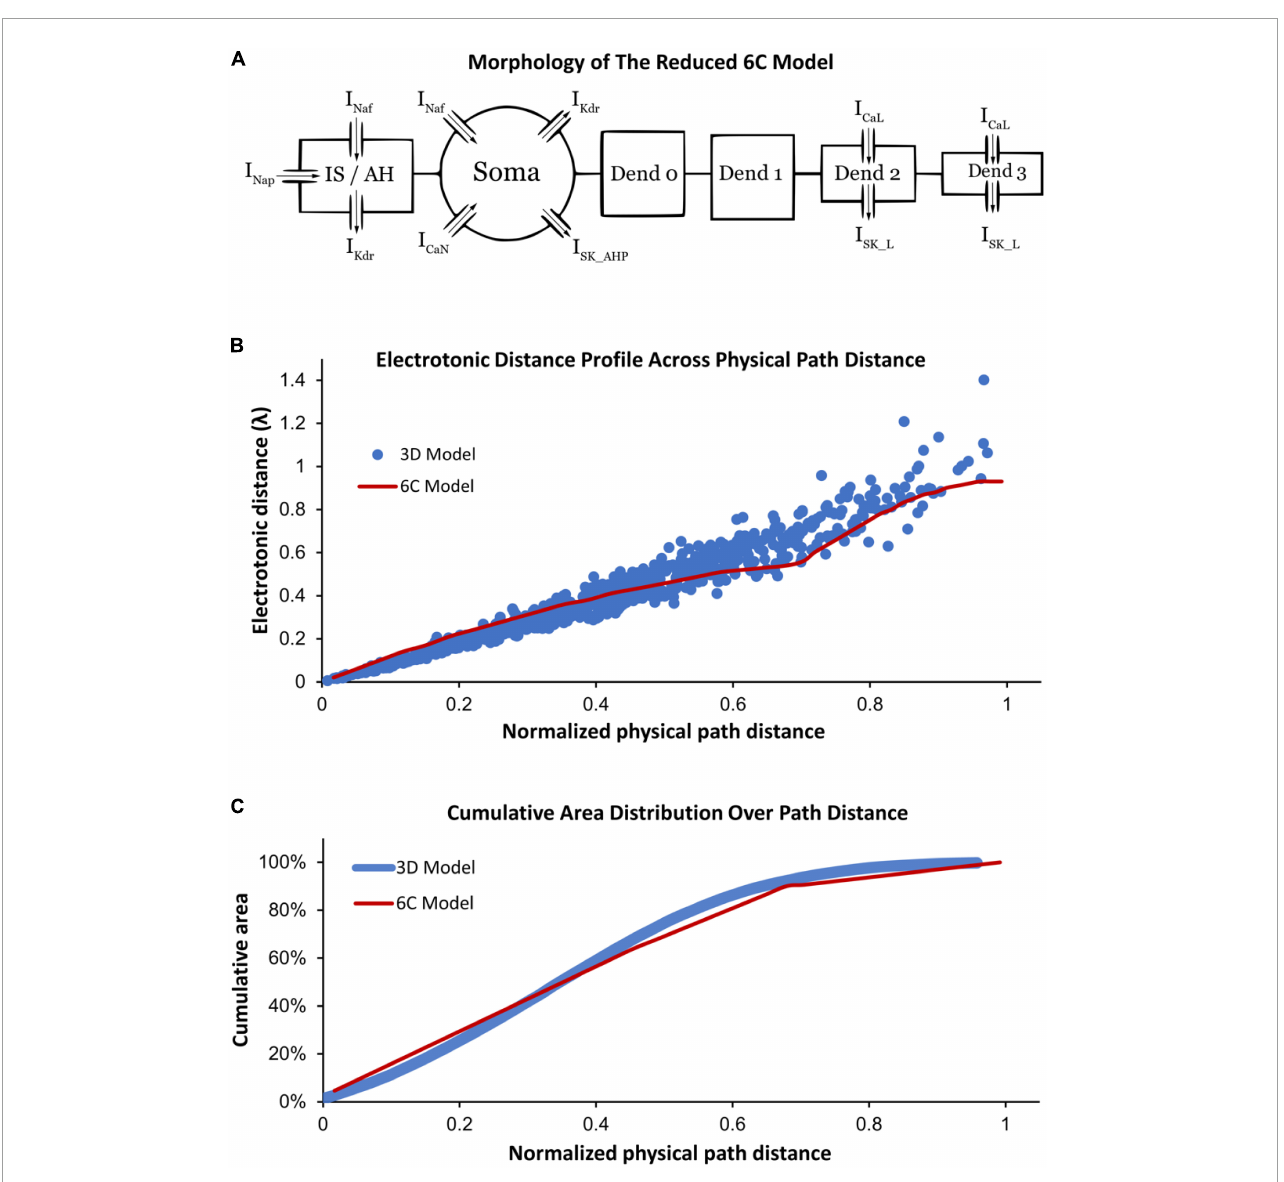
FIGURE1 (A) Morphology of the reduced six-compartment (6C) model in XPPAUT showing its compartments with their ion channels. The arrows refer to the current direction of each ion channel. (B) A comparison between the relationship of the physical path distance and electrotonic distance (in λ ) in the reduced 6C model in XPPAUT (red) vs. the 3D model of Mousa and Elbasiouny (2020) (blue). (C) A comparison between the cumulative area and physical path distance of the model compartments in the reduced 6C model in XPPAUT (red) and the 3D model of Mousa and Elbasiouny (2020) (blue). In panels (B,C) , the x -axes are normalized to the longest physical path distance of each